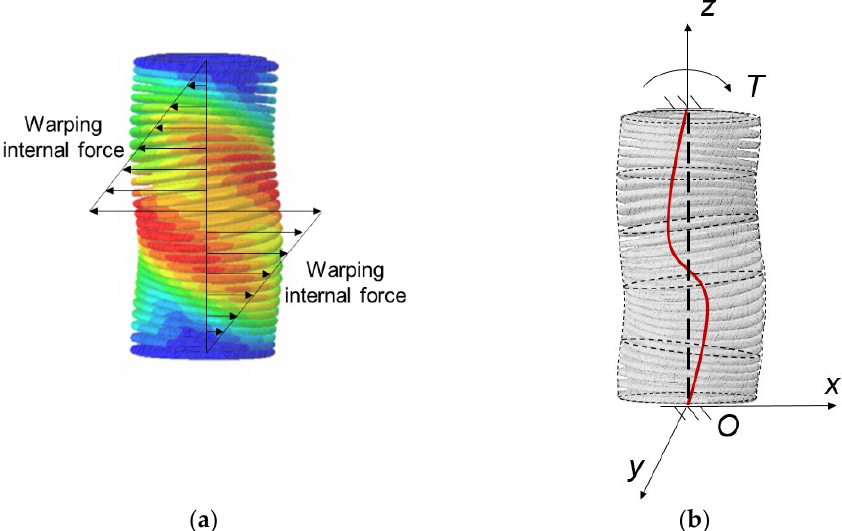
Figure 6. Deformation mechanism of U-shaped bellows; ( a ) warping internal force in the bellows and ( b ) torsional deformation of the bellows.